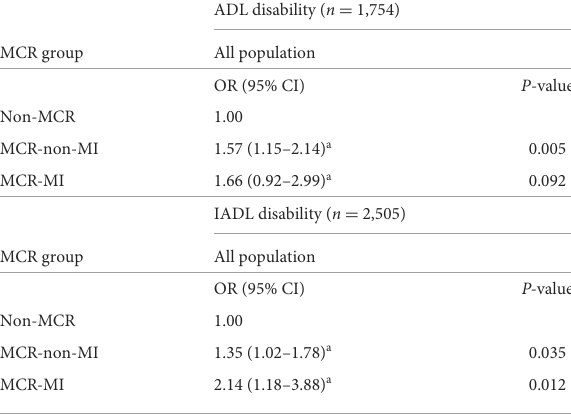
TABLE 4 Multiple logistic regressions presenting the longitudinal association of MCR subtypes with ADL disability and IADL